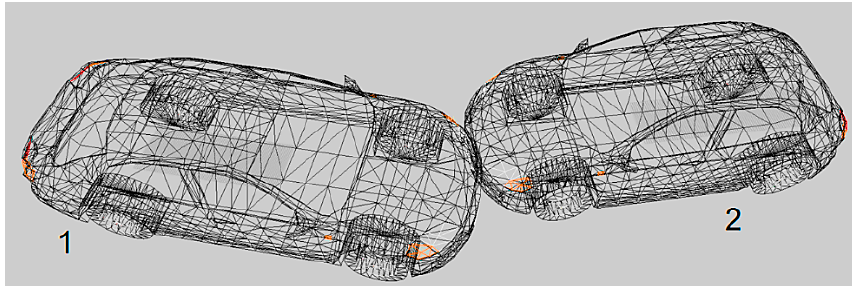
Figure 1. The mutual location of both vehicles at the beginning of the collision.